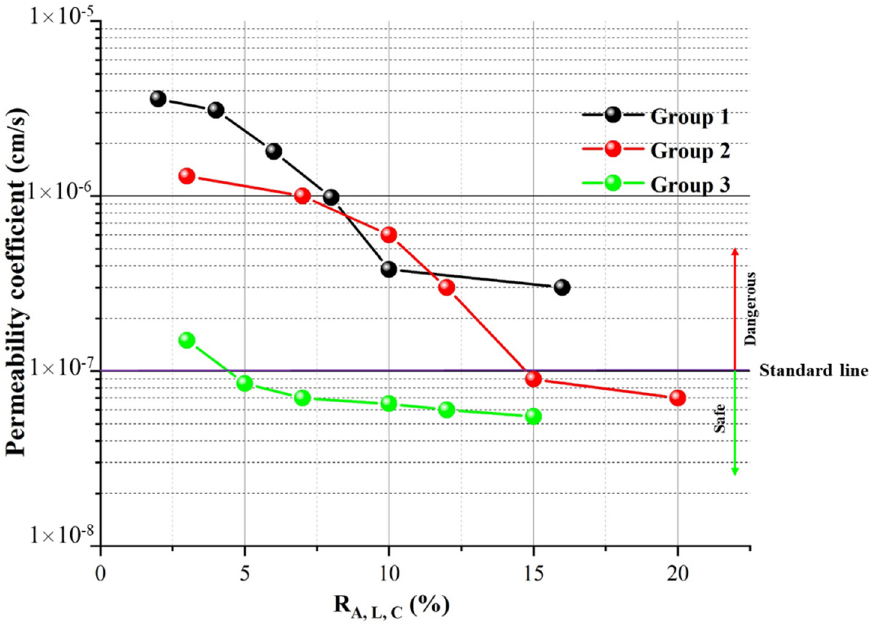
Figure 3. Permeation test results of three groups. (R—the percentage of material, A—attapulgite, L—lime, and